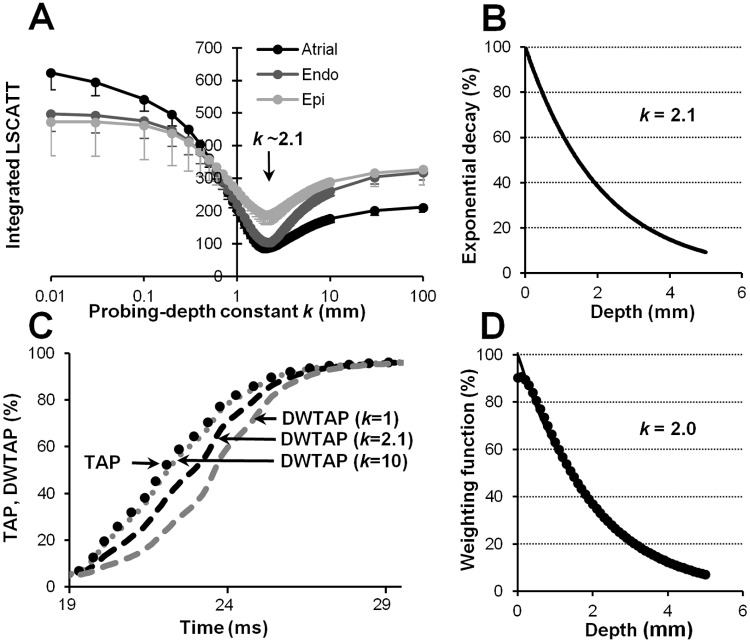
Detection of the probing-depth constant.(A) Dependence of LSCATT on the probing-depth constant of the fluorescence measurement for stimulations in the atrium (black line), endocardium (gray line), and epicardium (light gray line; n = 8 for each). The arrow indicates the minimum level of the integrated LSCATT when k = 2.1. The integrated LSCATT is given in units of the fluorescence intensity calculated as a percentage and multiplied by ms. (B) The exponential decay of the dependence of fluorescence probing on the depths under routine experiments was calculated using the formula exp(-z/k), where z is the depth of the myocardium (mm), and k = 2.1. (C) Averaged transmural upstrokes: traces of a calculated TAP (dotted line) versus the DWTAP, when k = 1 (dashed gray line), 2.1 (dashed black line), and 10 (short-dotted line). (D) The data points (from separate measurements of penetration depths) for the weighting function (filled circles) for the red excitation light (660 mm) and the near-infrared emission (735 mm) light are shown, together with a curve (solid line) depicting single exponential decay with a constant k = 2 mm, which was obtained by fitting the data for the weighting function.